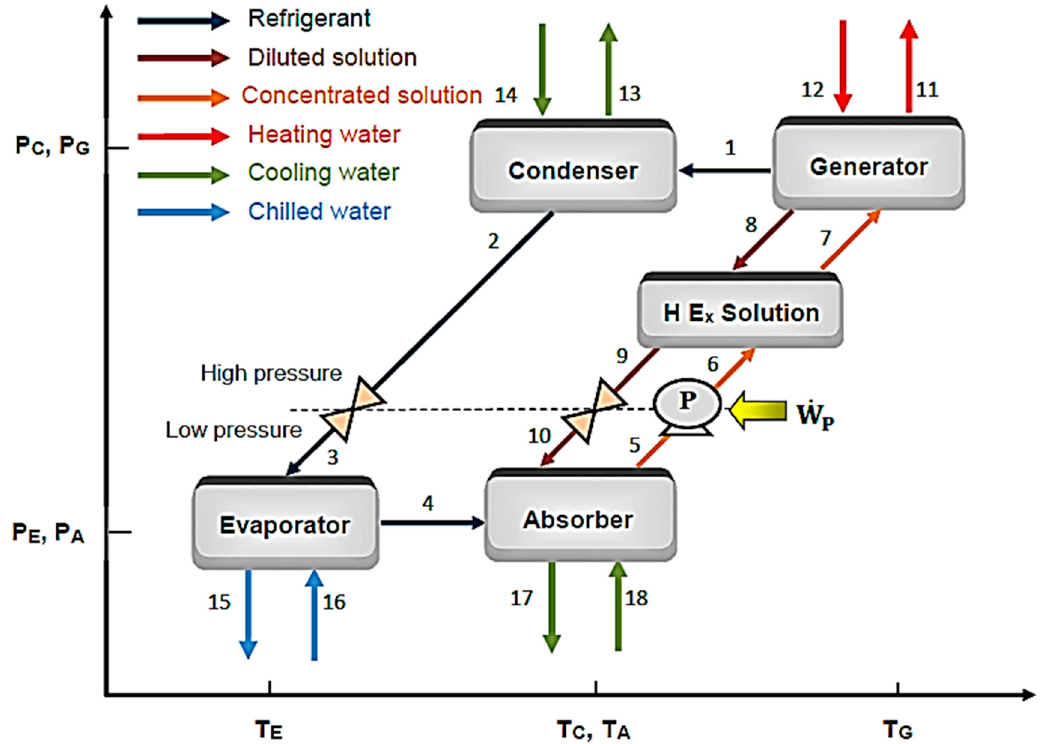
Figure 2. Schematic diagram showing the main components of an absorption system with rectifier and heat exchanger for the solution streams.